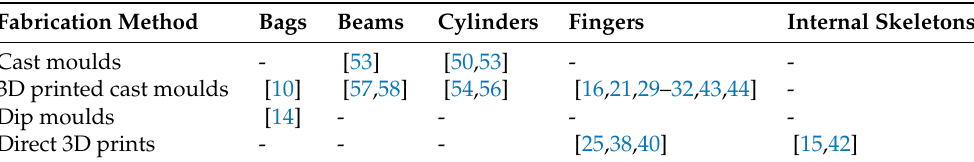
Table 7. Frequency of Fabrication Methods for Membranes.